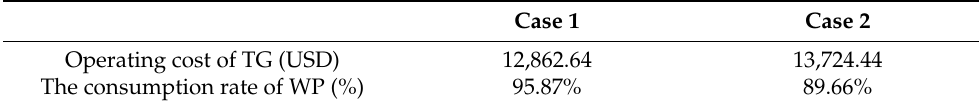
Table 3. Comparison of optimization results in